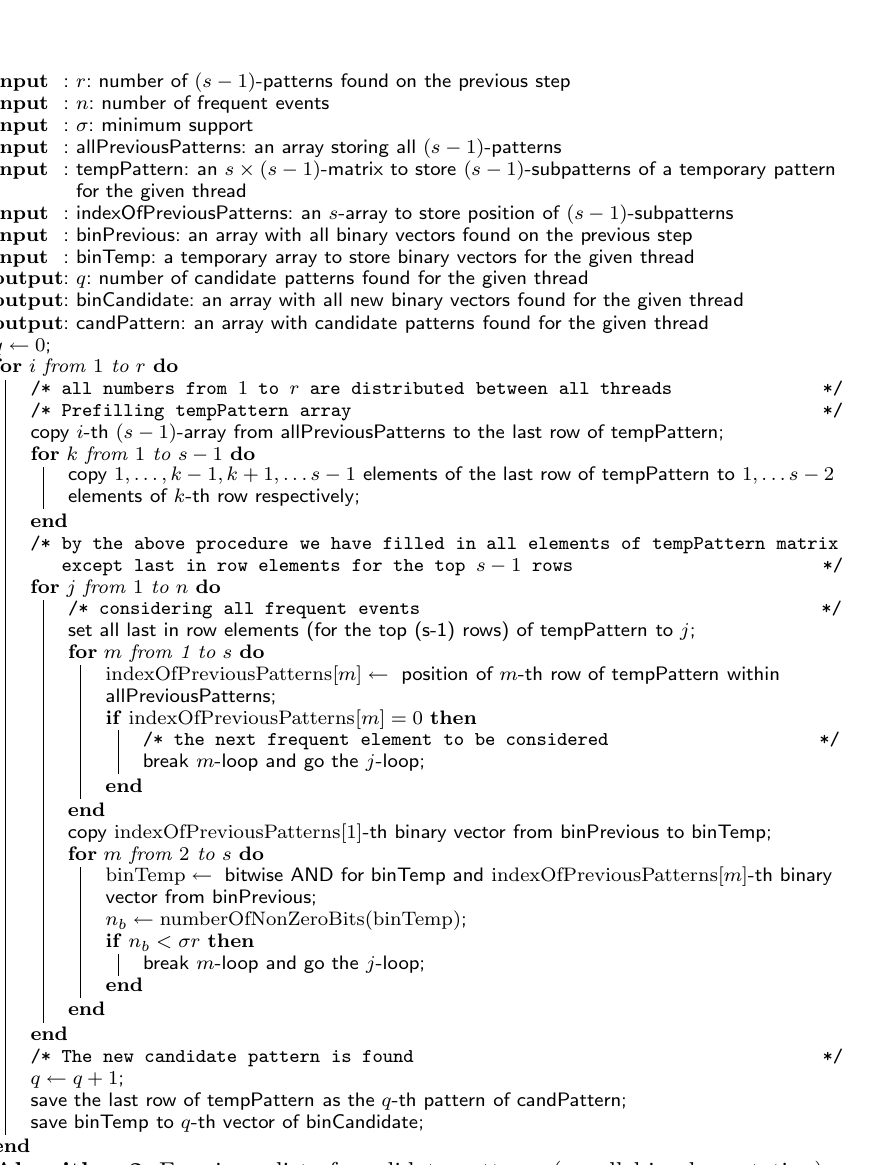
Algorithm 2: Forming alis t of candidate patterns (parallel